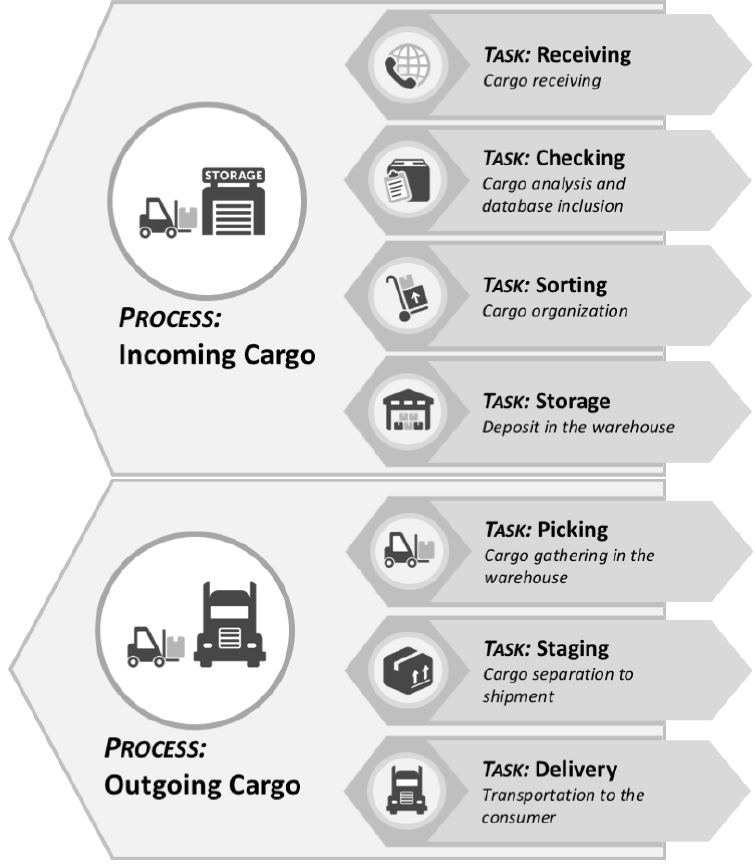
Figure 4. Description of processes, Incoming Cargo and Outgoing Cargo, and their tasks in warehouse logistics [42] (© 2020